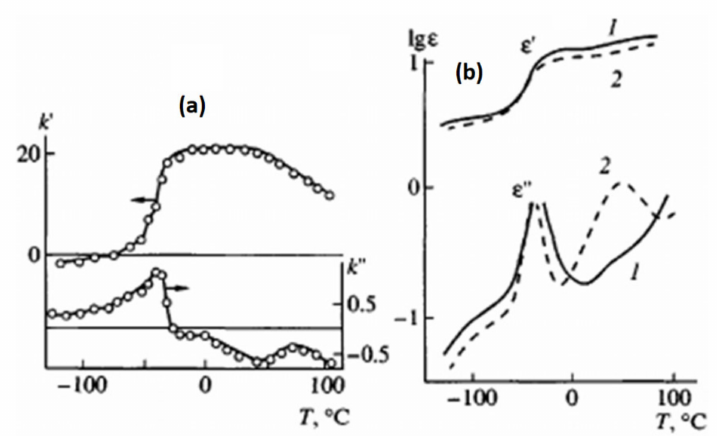
Figure 15. Temperature dependences of the components of the complex electrostriction constant ( a ) and permittivity ( b ) for oriented (1) and isotropic (2) PVDF films [119]. Reprinted/adapted with permission from Ref. [119]. 2022, AIP